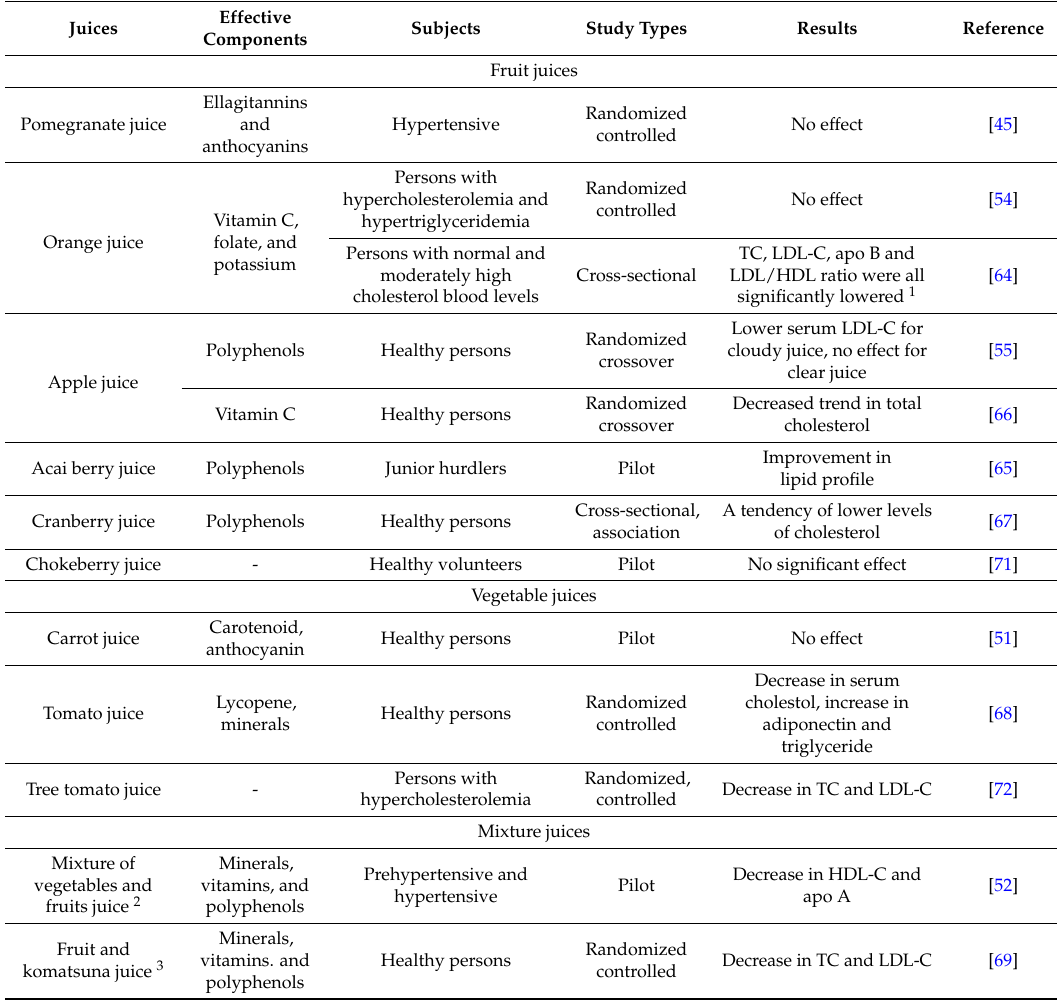
Table 2. Effects of juices on blood